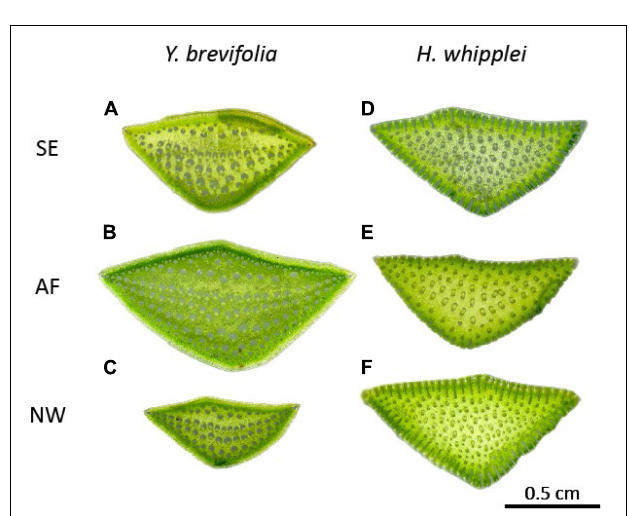
FIGURE 2 | Leaf cross-sections of Y. brevifolia and H. whipplei from different microhabitats in the West Mojave Desert. Y. bevifolia (A–C) and H. whipplei (D–F) cross sections showing vascular bundles. SE, south-eastern slope; AF, alluvial fan; NW, north-western slope. n = 5 leaves per species per site.